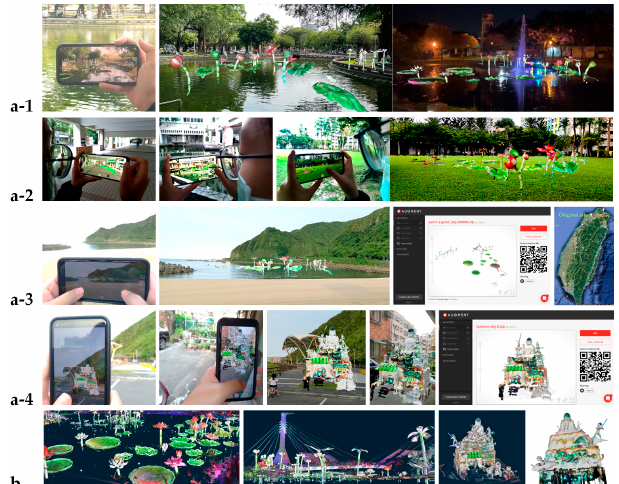
Figure 11. AR field experiences were simulated by applying two AR models from the 2016 TLF on the Augment ® platform at new sites, during the day and night: ( a-1 ) in a park, ( a-2 ) on a campus lawn, ( a-3 ) on a beach, and ( a-4 ) on a street; ( b ) original color point-cloud model.